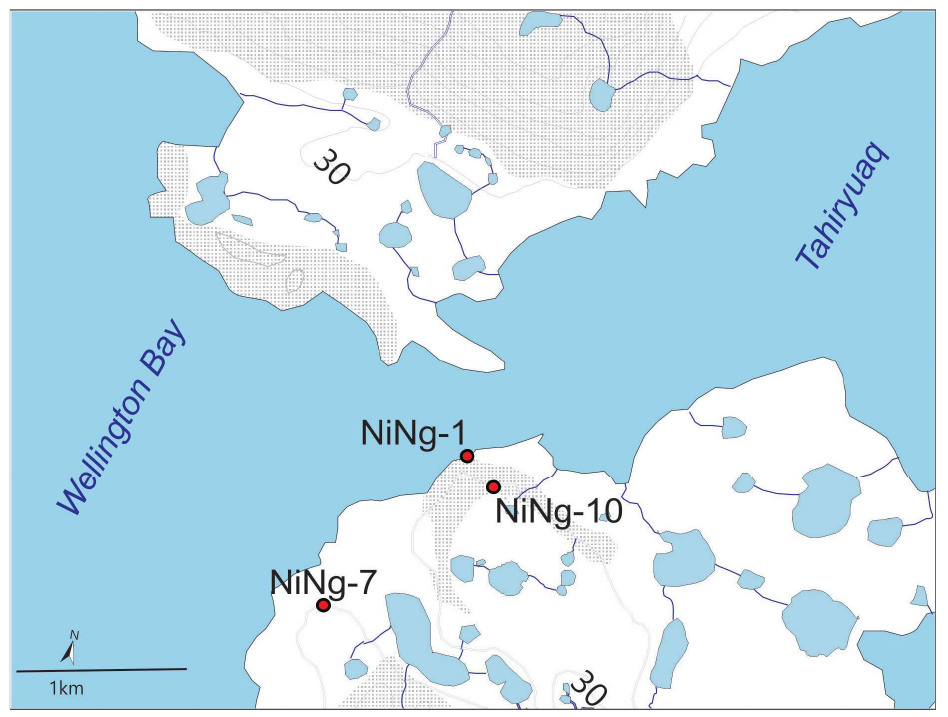
Figure 5. Pre-Dorset (3100–2900 cal B.P) site location situated on proposed paleogeography at approximately 3400 cal B.P. Marine limit would have been at the modern 20 m contour.